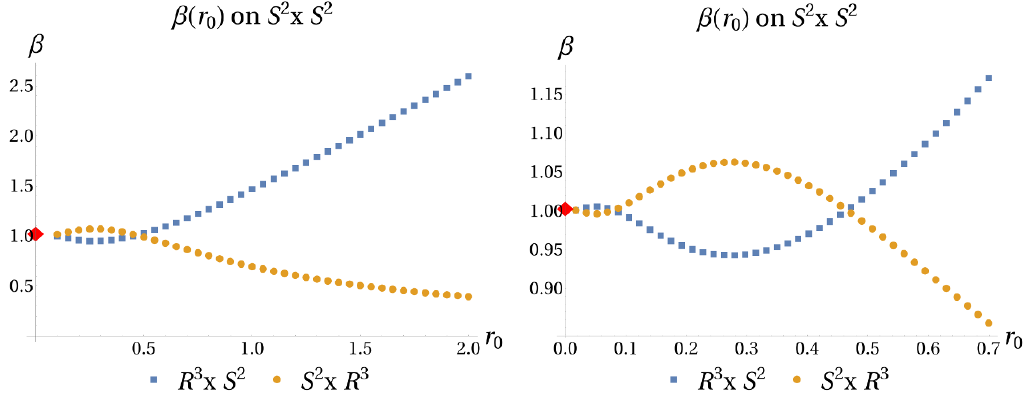
Figure 5 . The ratio of radii (cid:12) as a function of the closing radius r 0 for both topologies with conformal boundary S 2 (cid:2) S 2 . The red diamond is the analytical calculation for the singular ratio (cid:12) s .